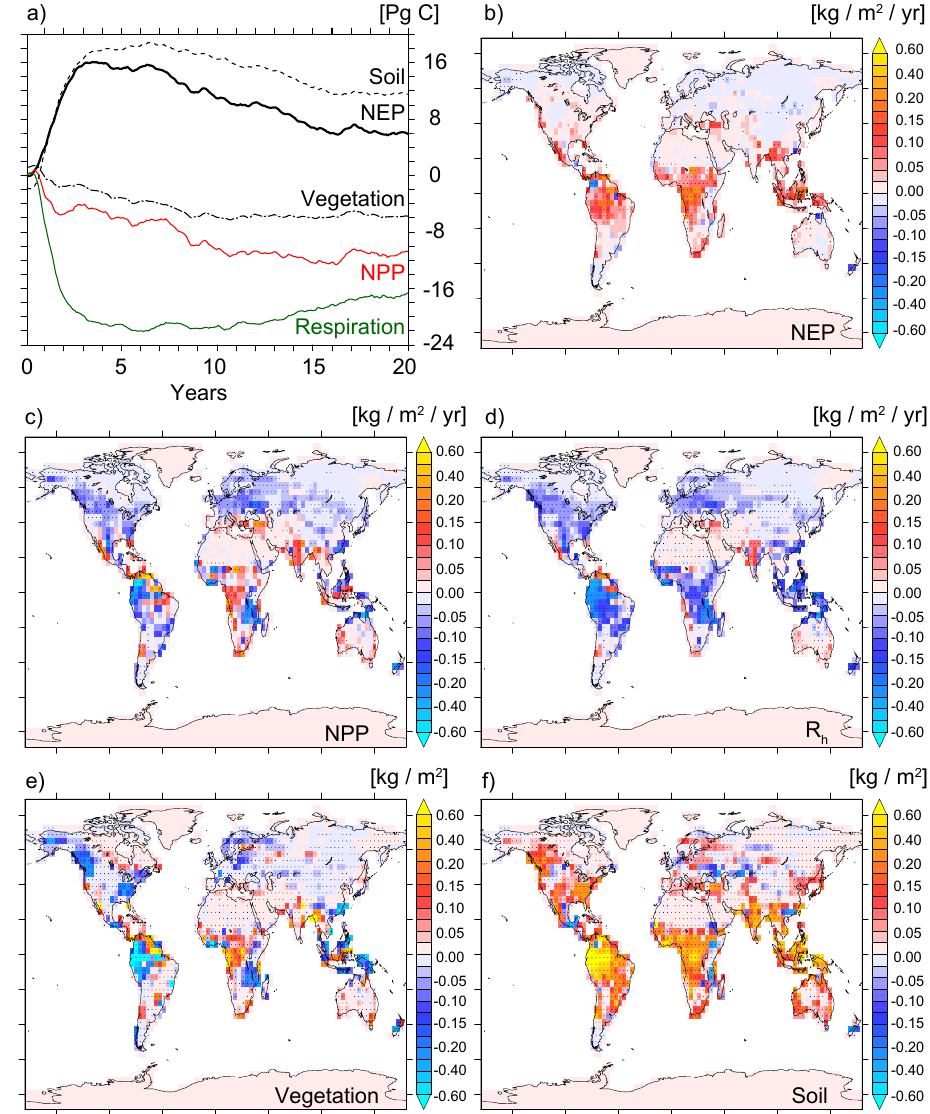
Fig. 6. Evolution of land carbon inventory changes and associated mechanism. (a) Monthly, deseasonalized anomalies of soil and vegetation carbon inventories (black dashed lines), time-integrated NEP (solid black), NPP (red) and R h (green) for the Pin.10x case. (b–f) Changes in (b) NEP, (c) NPP, (d) R h , (e) vegetation carbon inventory, and (f) soil carbon inventory averaged over the first 5yr for the Pin.10x case. Net ecosystem production (NEP) is the difference between NPP and R h . Stippling in (b–f) denotes grid cells where the magnitude of changes are significant at the 5% level based on a two-sided Student’s